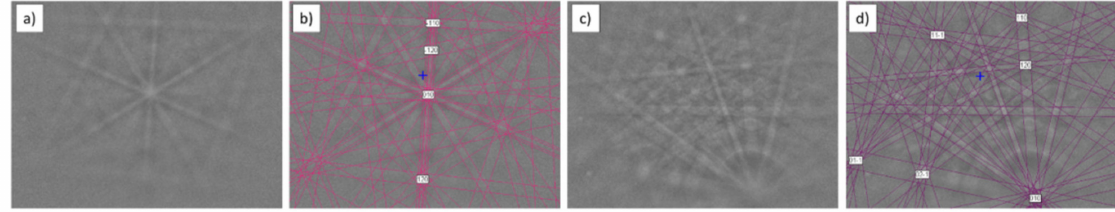
Figure 10. EBSD analysis of Ti-2.0%TiC sinter: ( a ) Kikuchi pattern of Ti 5.73 C 3.72 phase; ( b ) indexed Kikuchi pattern of Ti 5.73 C 3.72 phase; ( c ) Kikuchi pattern of TiB phase; ( d ) indexed Kikuchi pattern of TiB phase.